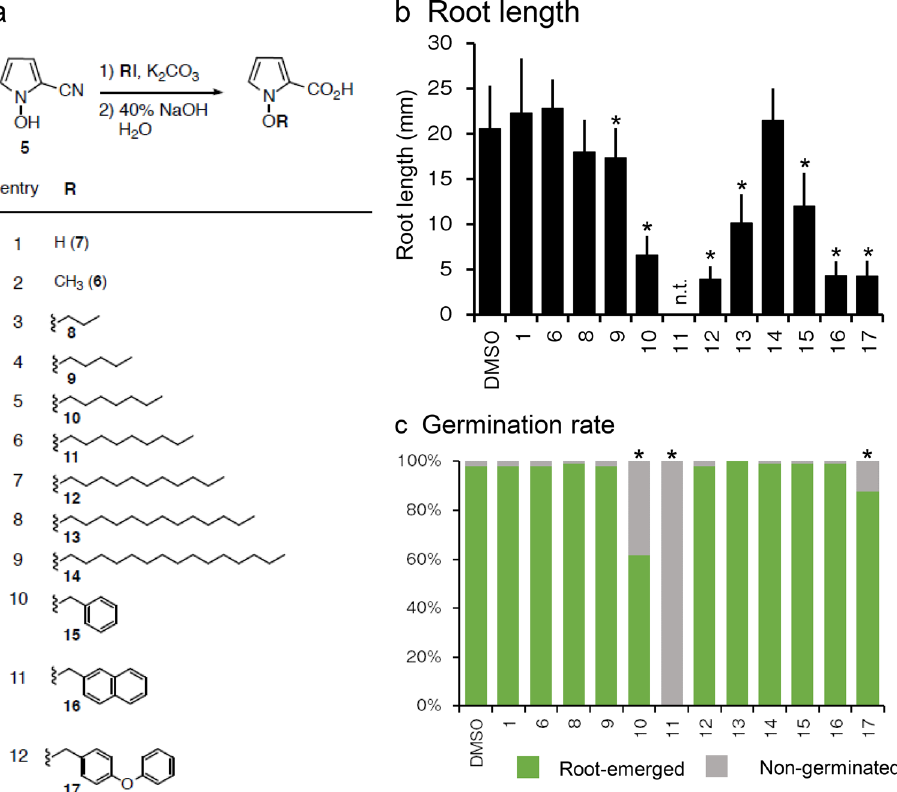
Figure 3. Structure–activity relationship study of kumamonamide and its related compounds. ( a ) The structure of and synthetic protocols for analogues. ( b ) Quantification of the root lengths of the 7-day-old seedlings grown on MS media with or without 50 μM kumamonamide derivatives. Asterisks indicate significant differences from mock treatment ( t -tests, p < 0.05). n > 18. Data are shown as mean ± SD. n.t. indicates not tested due to more than 50% of seeds were not germinated. ( c ) Quantification of the germination rate of the 7-day-treated seeds incubated on MS media with or without 200 μM kumamonamide and its related compounds. Asterisks indicate significant differences from mock treatment (chi-square tests). n =